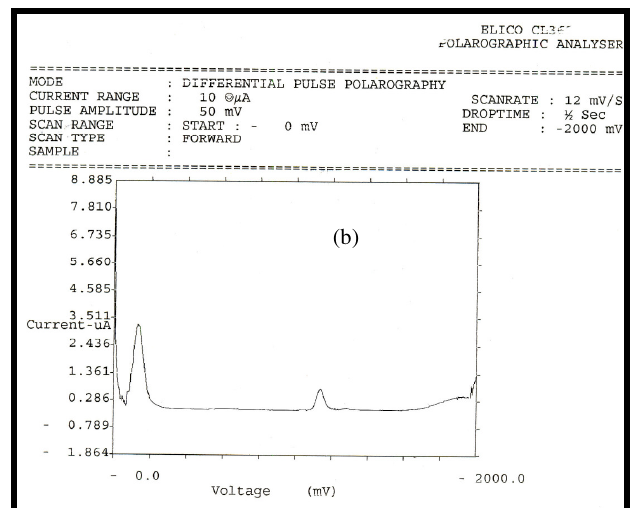
Figure 1. (a) Direct current authentic polarogram of paracetamol in Britton Robinson buffer (1 M) at pH 7.2±0.1; (b) Different pulse polarogram of authentic paracetamol in Britton Robinson buffer (1 M) at pH